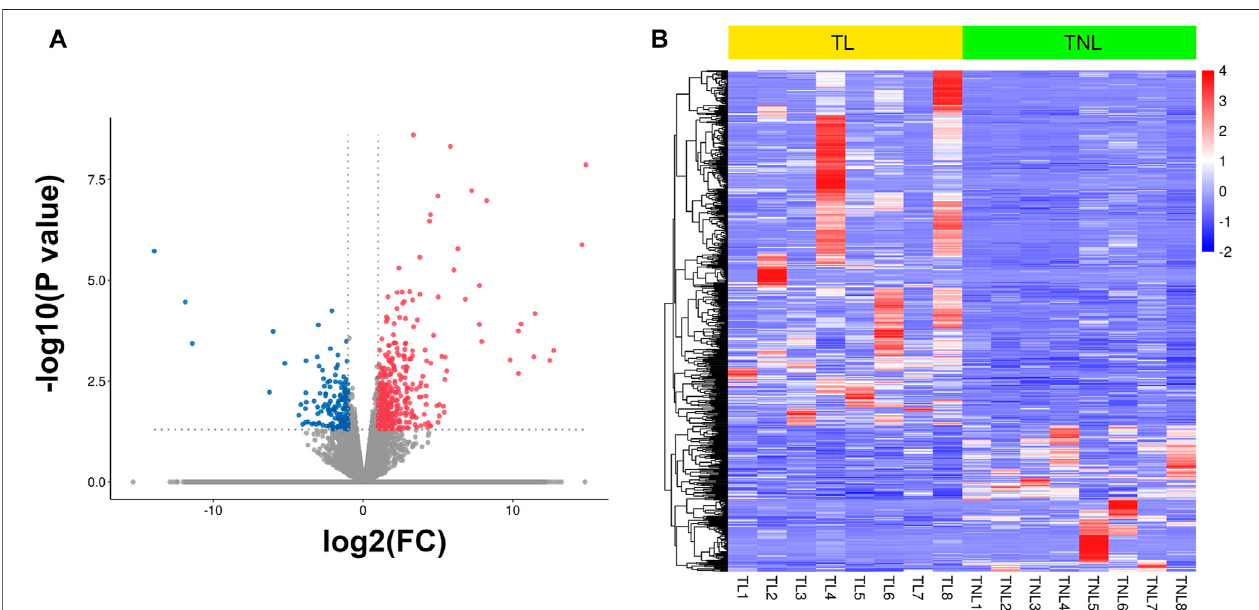
FIGURE 1 | Myometrial transcriptional signatures at spontaneous human term labor (TL) and at term not in labor (TNL). (A) Volcano plot of distribution trends for differentially expressed genes (DEGs) between TNL and TL. Up-regulated genes are presented as red dots and down-regulated are blue. (B) Heatmap of expression levels for all DEGs between TL and TNL myometrium. High expression levels are shown in red, while low expression levels are in blue. Color key equals log2 expression